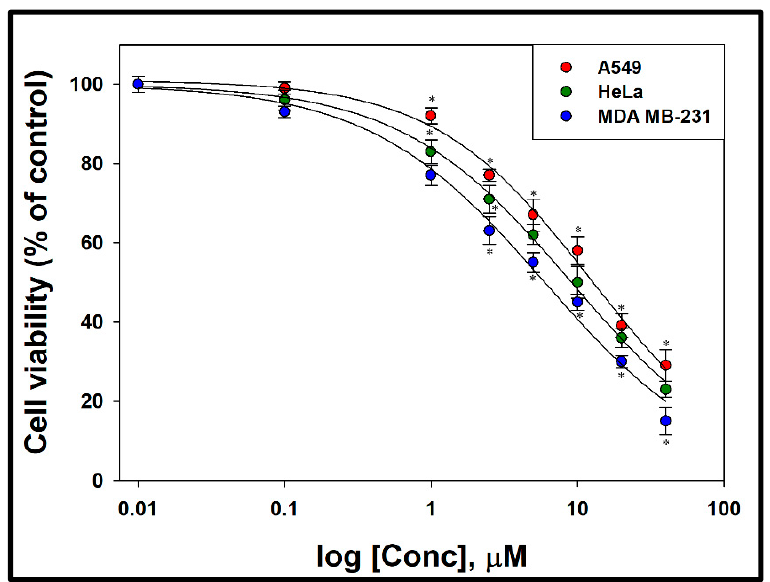
Figure 2. Cytotoxicity of compound 1 on MDA-MB cells, HeLa cells, and A549 cells treated in concentrations as indicated for 24 h and analyzed by MTT assay (All data are expressed as mean ± SE from three independent experiments). * Significant ( p < 0.05) compared with corresponding controls.